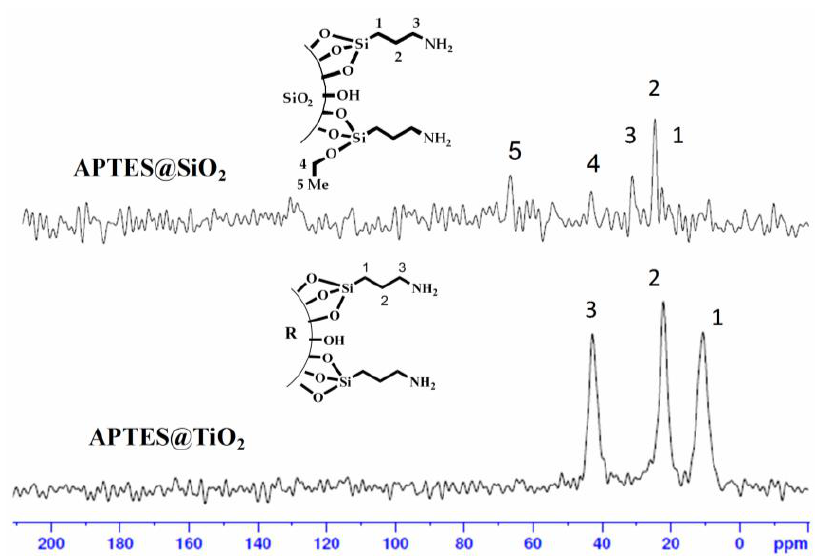
Figure 10. Solid State 13 C CPMAS NMR spectra of APTES@SiO 2 and APTES@TiO 2 .